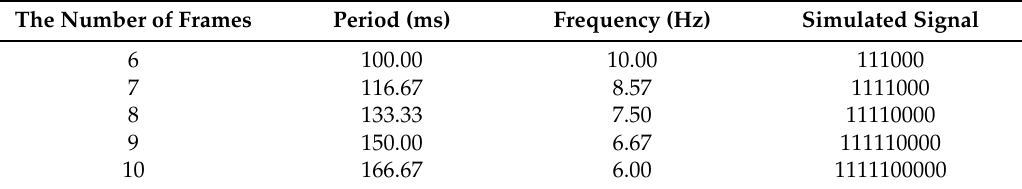
Table 1. Frequencies for a screen with a refresh rate of 60 Hz.